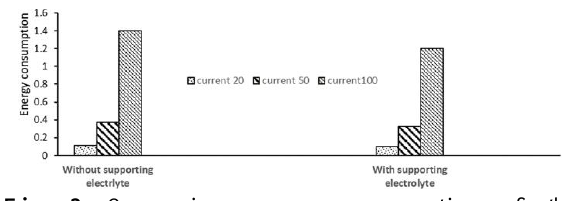
Fig.2c Percentage of live bacteria after electrochemical disinfection containing steel mesh electrode Pseudomonas aeruginosa